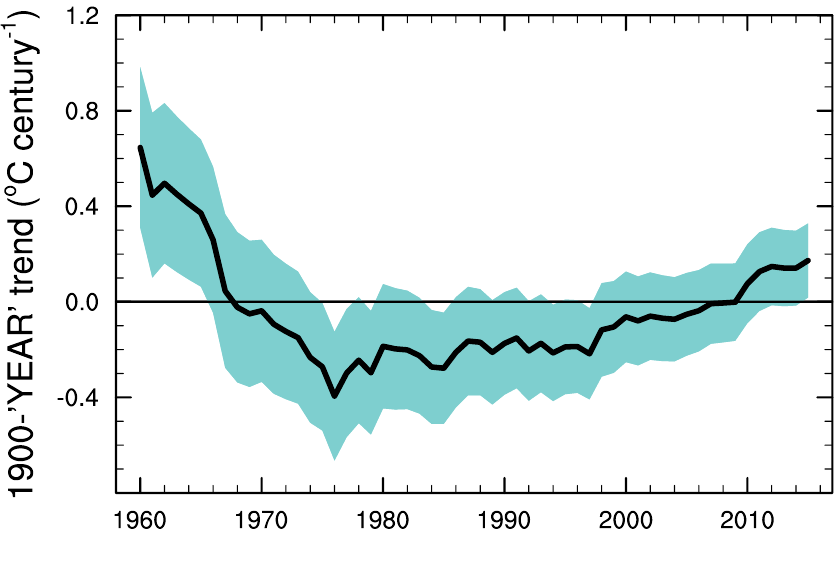
. Figure 3. Time series of the 1900 to “year” linear trend (least-squares) for each “year” from 1960 to 2015. The green shaded region represents the error estimate (95% confidence) of the linear trend.